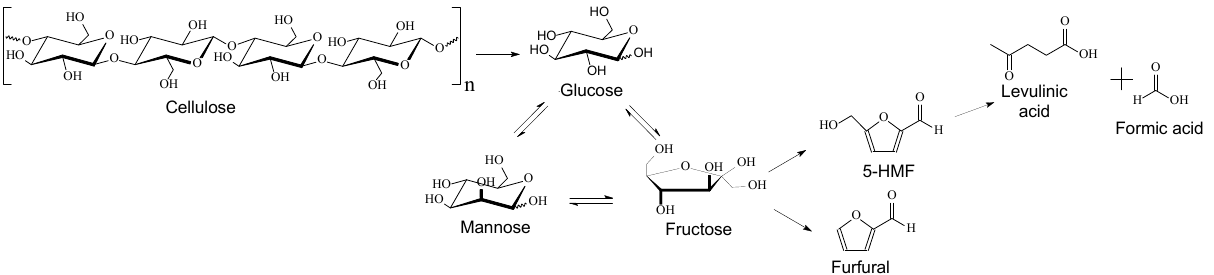
a Reaction conditions: initial concentrations of cellulose and catalyst 10 g · L − 1 , reaction volume 45 mL, 453 K, P time 7 h; b Cellulose conversion revealed by TOC at 7 h of the reaction; c mmol (5-HMF + Glu) · g − 1 · h − 1 .